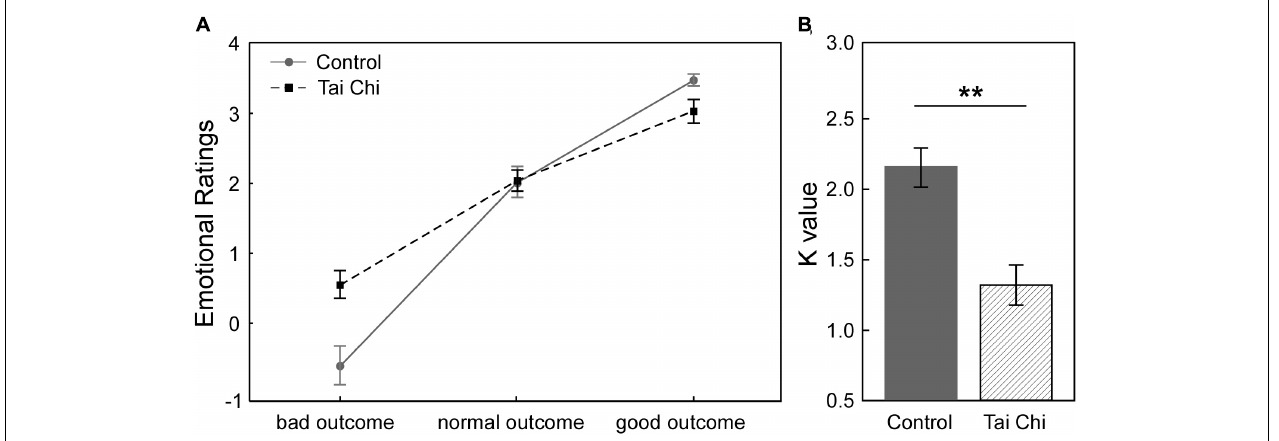
FIGURE 1 | (A) In Gain condition, the relationship between subjective emotional ratings and objective outcomes (bad outcome, normal outcome, and good outcome) of two groups. (B) The comparison about emotional stability between two groups. The result showed that K -value in Tai Chi group was significantly